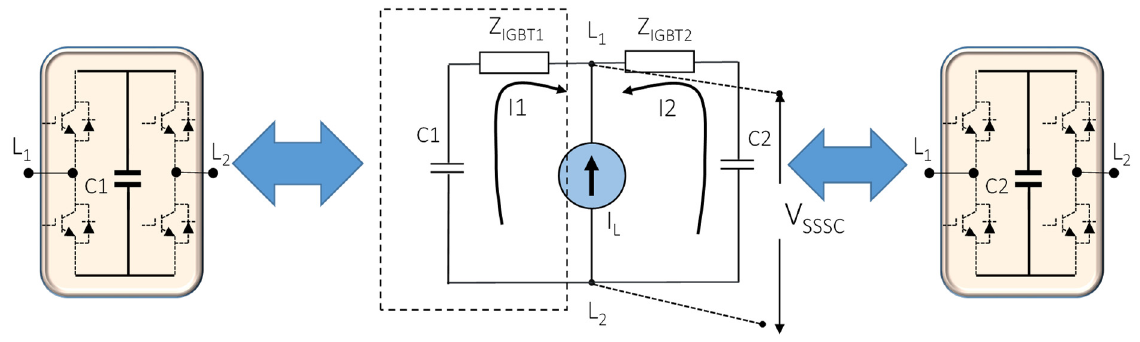
Figure 8. Self-balancing